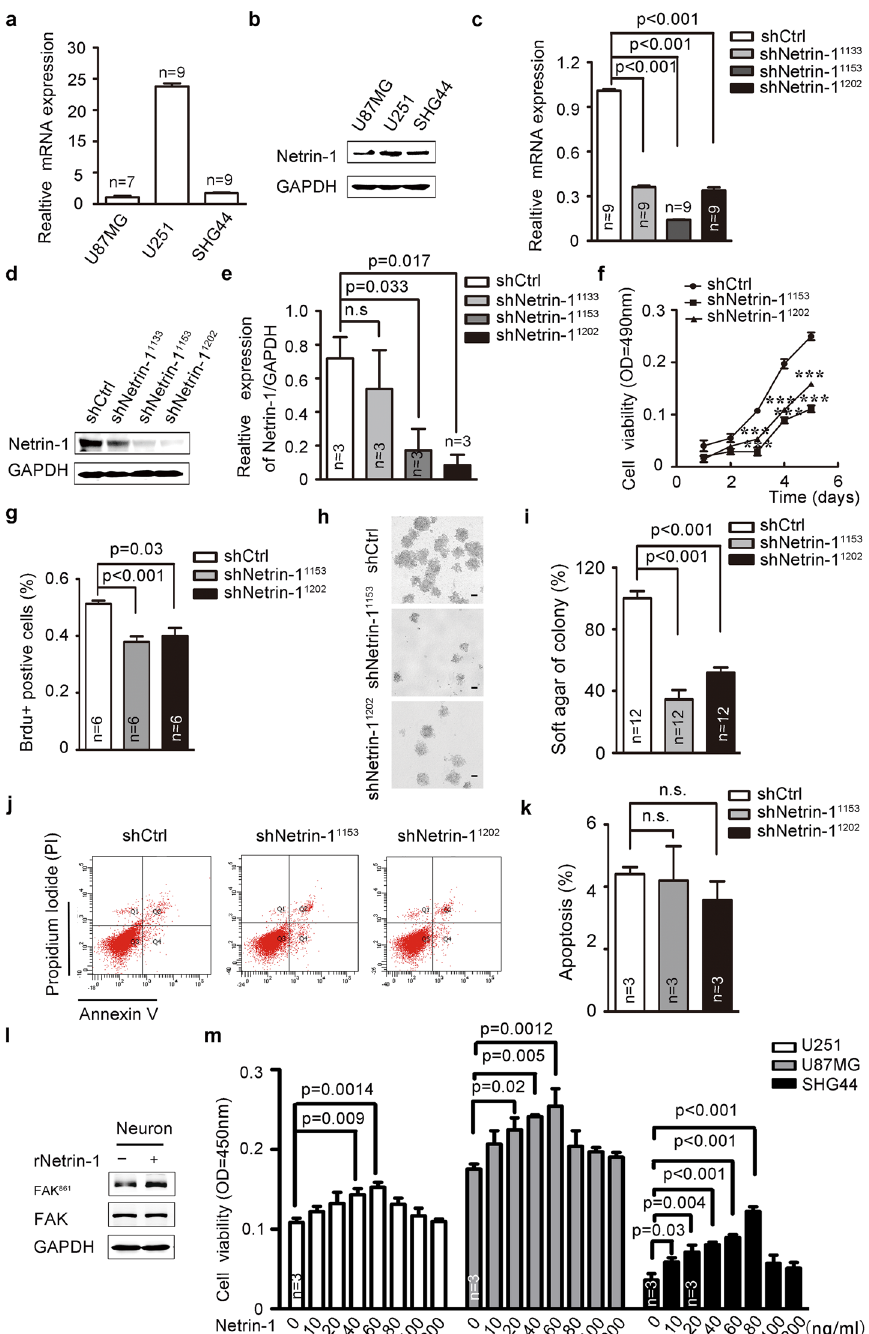
Figure 3. Netrin-1 was required for cell proliferation in cultured glioma cells. ( a and b ) Netrin-1 mRNA and protein levels were determined by real-time PCR and western blotting in three cultured glioma cells. ( c and d ) Detection of netrin-1 expression by real-time PCR and western blotting in U251 cells infected with lentivirus expressing shCtrl or shNetrin-1. GAPDH was used as a loading control in both assays. ( e ) Quantification of netrin-1 expression using Gel-Pro Analyzer 4 software. ( f ) MTT assays were used to determine the cell viability of U251 cells infected with lentivirus expressing shCtrl or shNetrin-1. ( g ) BrdU analysis was performed to detect cell proliferation in U251 cells infected with lentivirus expressing shCtrl or shNetrin-1. ( h ) U251-shCtrl or shNetrin-1 cells were plated in 0.3% soft agar. Three thousand cells were incubated for 16 days, and the media was changed every 2 days. Cells were counted using a dissecting microscope. Scale bar: 50 μ m. ( i ) The colony formation assays were quantified by counting the number of colonies. ( j and k ) Apoptosis was measured by flow cytometry of U251 cells after infection with lentivirus expressing shCtrl or shNetrin-1. ( l ) Cells were treated with recombinant netrin-1. Phosphorylated FAK 861 was detected by western blotting. ( m ) U251, SHG44 and U87MG cells were treated with increasing concentrations of recombinant human netrin-1. Cell viability was determined by CCK-8 assay after the addition of netrin-1 for 48 h. The data are shown as the mean ± SEM. n.s., P >